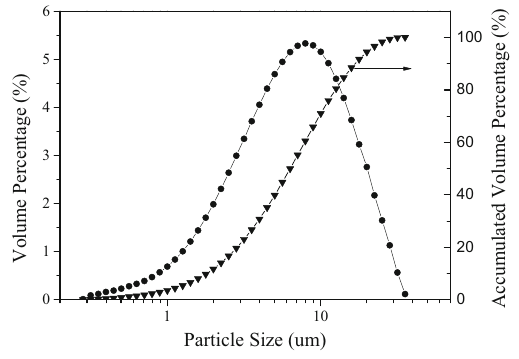
Fig. 5 Particle size distribution of fly ash